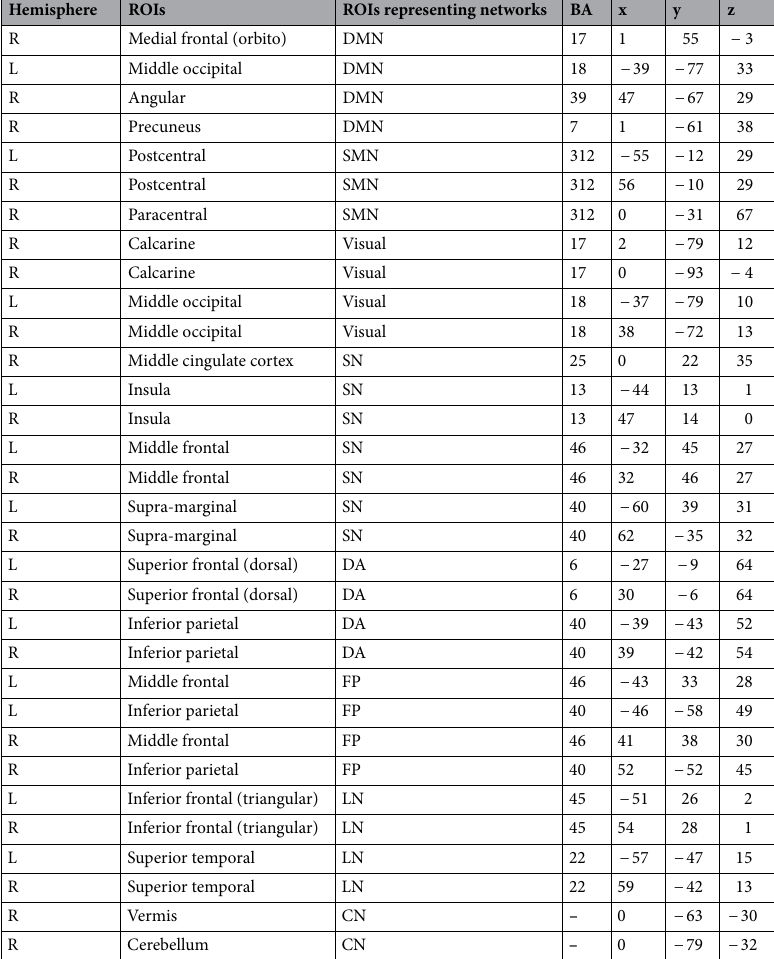
Table 1. Thirty-two seed regions as regions of interest (ROIs) involving 8 major functional brain networks for network configuration. BA Brodmann area, CN cerebellar network, DA dorsal attention, DMN default